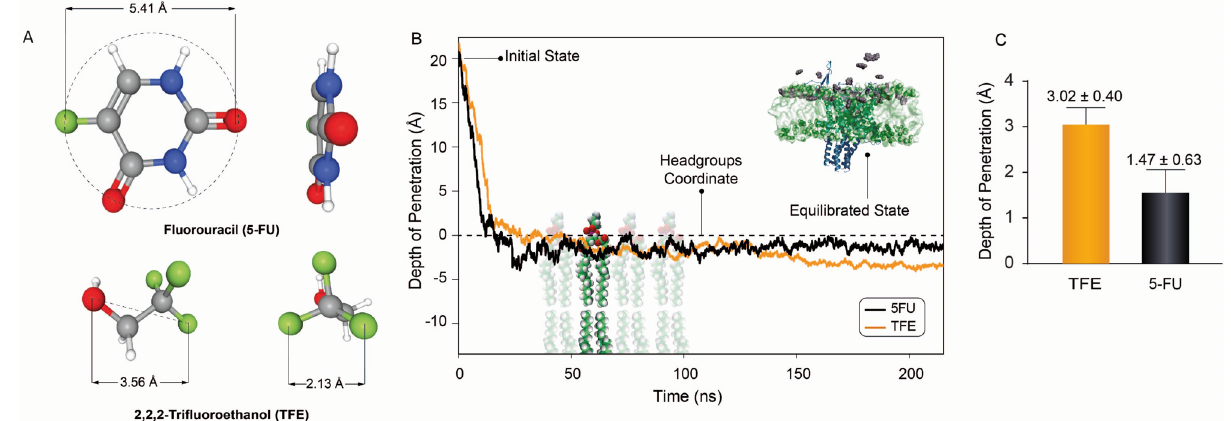
Figure 1. Schematics of 5-Fu and TFE molecules and their interaction with a POPE membrane (based on their equilibrium state). ( A ) timeline of the drug’s diffusion into lipid bilayer ( B ), and averaged depth of the penetration over the simulation time ( C ). Inset shows the adsorption of 5-FU (grey) into a POPE lipid bilayer (green) containing MscL (cyan). The phosphate atoms of the bilayer have been represented as grey spheres to better visualize the lipid-water interface. As it can be seen from ( A ), the 5-FU molecule is completely planner. The Topological Polar Surface Area of 5-FU is 58.2 Å 2 , while this value has been reported 20.2 Å 2 for TFE molecules. ( C ) The mean penetration depths of TFE and 5-FU molecules are − 3.02 ± 0.40 Å and − 1.47 ± 0.63, Å respectively (mean ± SD, the changes are statistically significant; P < 0.05; Student’s t-test was